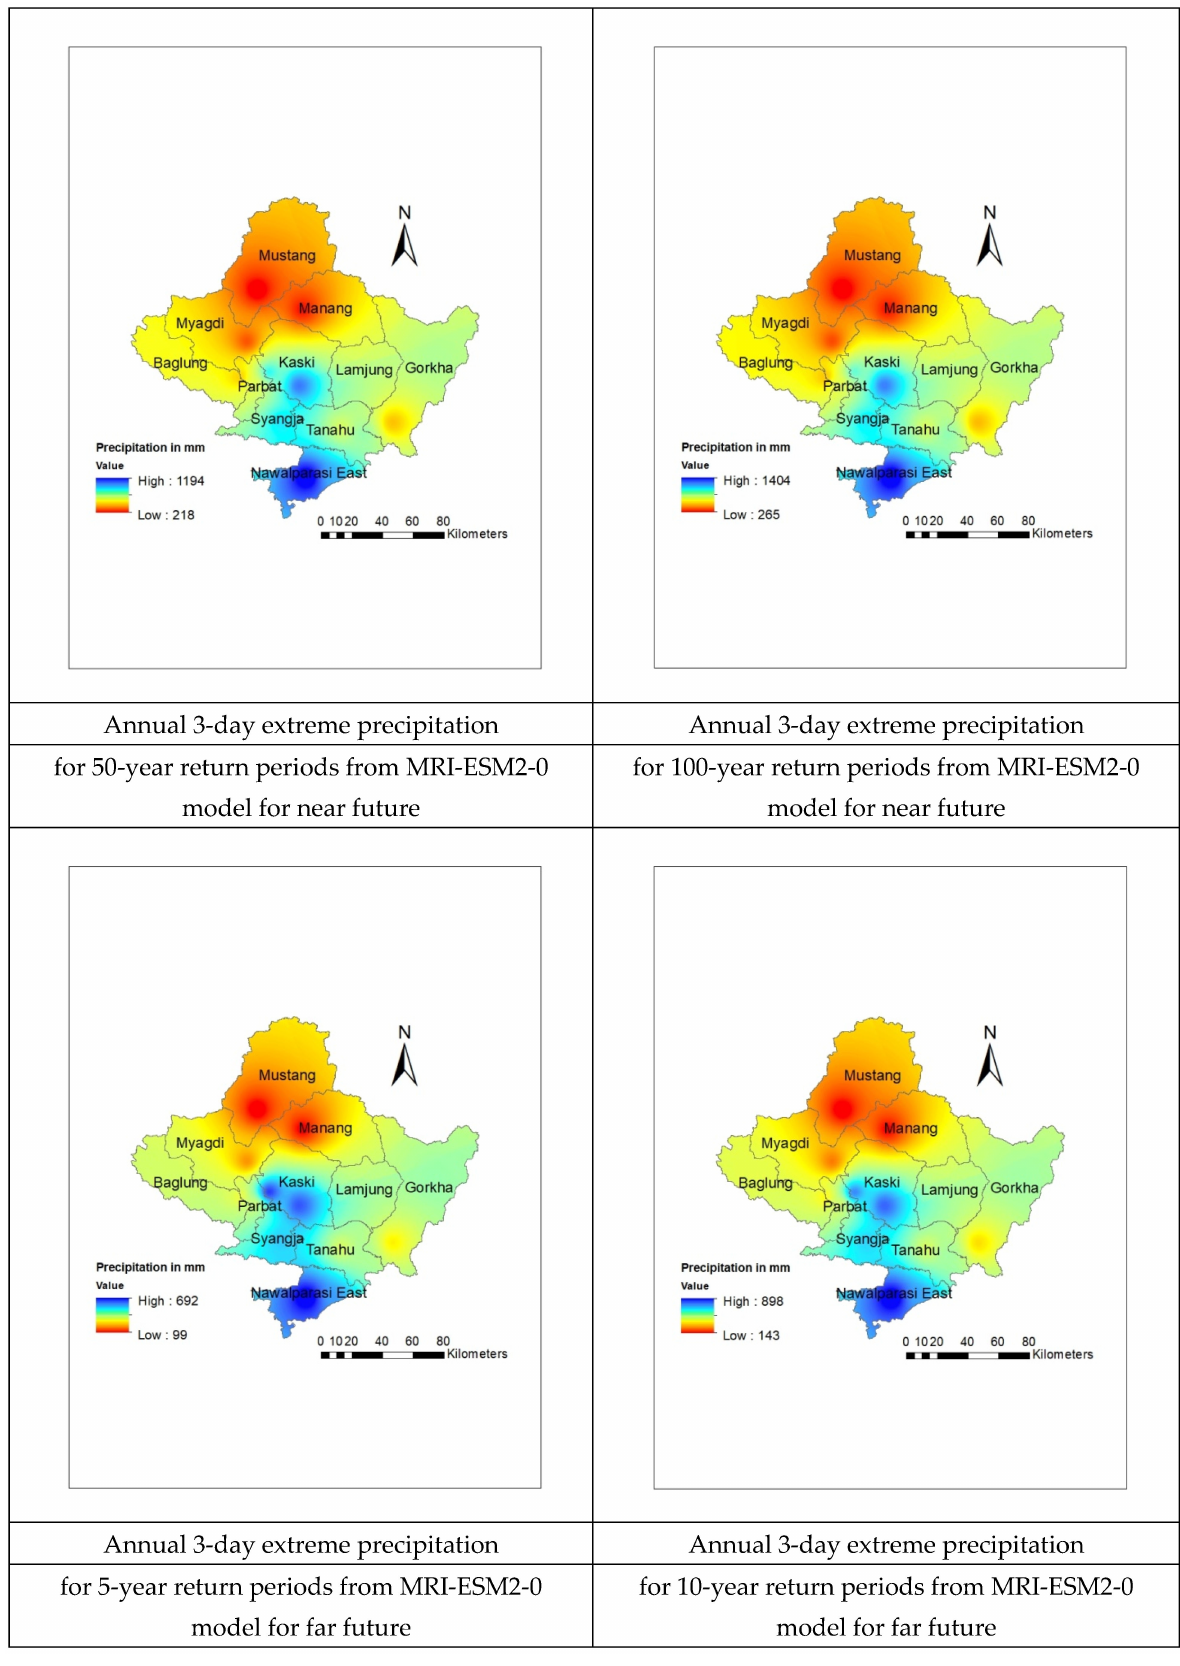
Figure A16. Cont